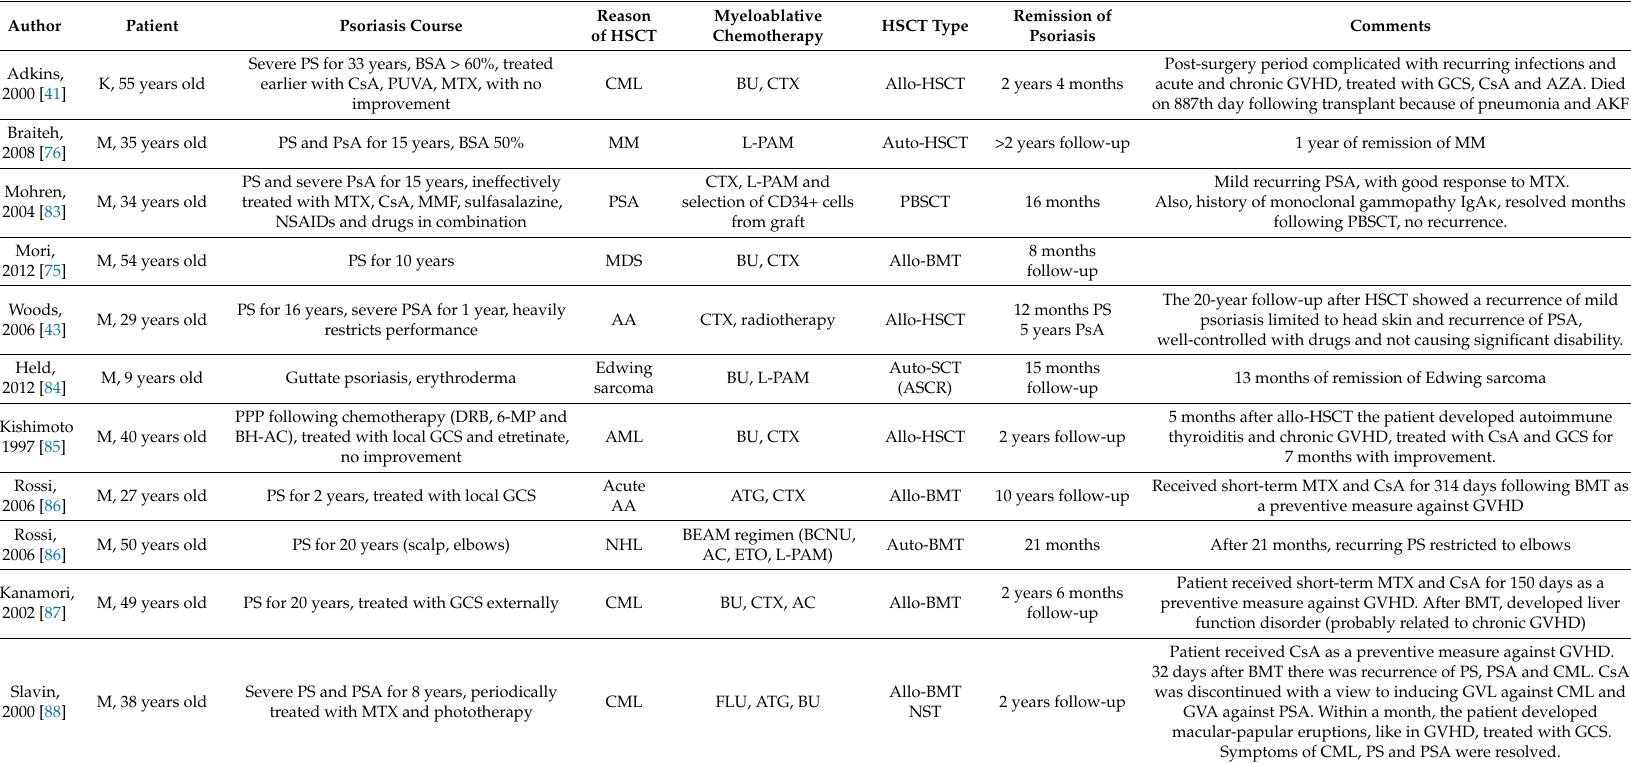
Table 2. Psoriasis remission due to autologous haematopoietic stem cell